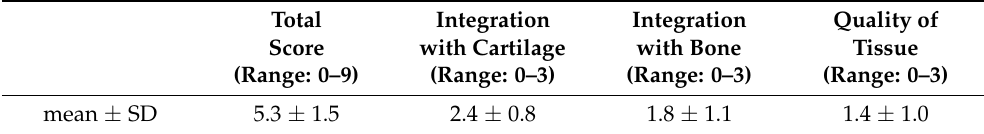
Quality of Tissue (Range: 0–3)